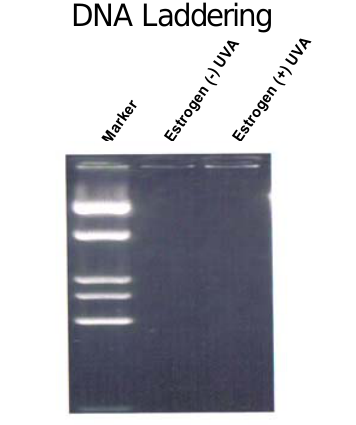
Figure 4: Comet assay of Jurkat T cells treated with estrogen ± UVA where Y-axis is the percentage of DNA Cleavage and x-axis is the different concentrations of estrogen used in comparison with controls which had no estrogen.